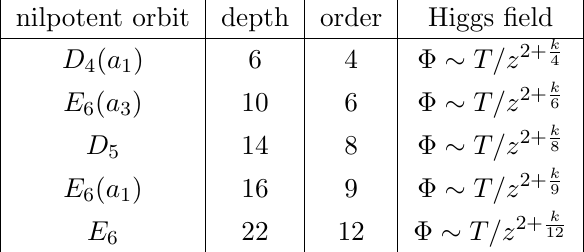
Table 11 . Summary of nilpotent elements of regular semi-simple type in E 6 .